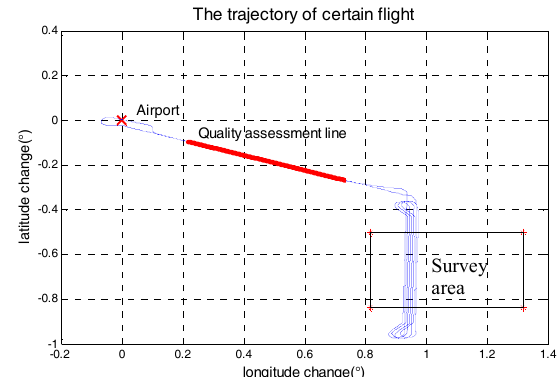
Figure 3. Appearance of aircraft Y-12.